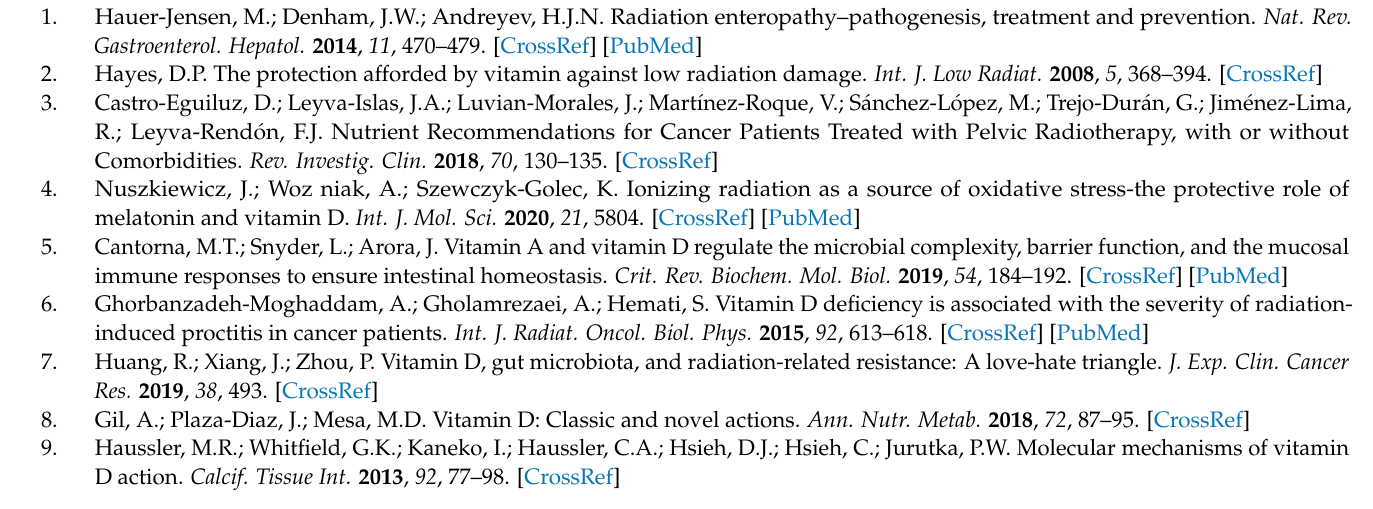
microscope, Figure S2. RT-qPCR results testing the knockdown efficiency of different pairs of